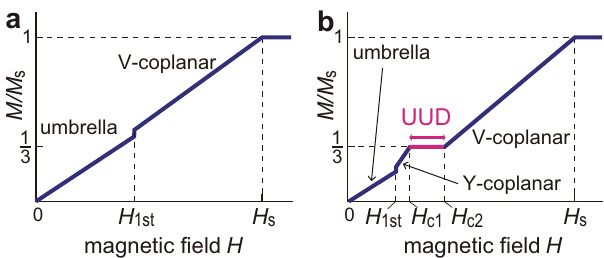
Fig. 3 Magnetization processes. Sketches of the magnetization possesses of the coupled-chain compound CsCuCl 3 a in the semiclassical regime under ambient or low pressure and b in the highly quantum regime under high pressure. The phase transition points ( H 1st , H c1 , H c2 ) and the saturation fi eld ( H s ) are marked on the